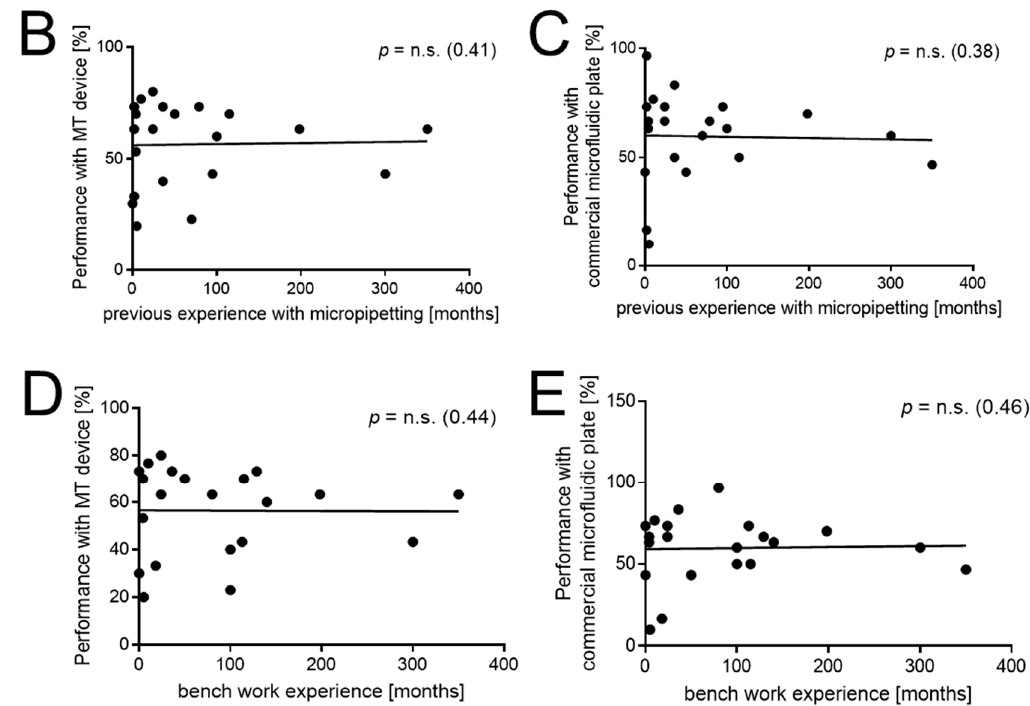
Figure 5. Cultural background and previous experience in micropipetting of volunteers enrolled in Pilot study 1. ( A ) Type of degrees of the volunteers enrolled in Pilot study 1 ( n = 21); ( B ) Correlation between previous experience in micropipetting and performance with MT device (%); ( C ) Correlation between previous experience in micropipetting and performance with commercial microfluidic plate [%]; ( D ) Correlation between previous experience in bench work and performance with MT device [%]; ( E ) Correlation between previous experience in bench work and performance with commercial microfluidic plate [%]. n.s., not significant.